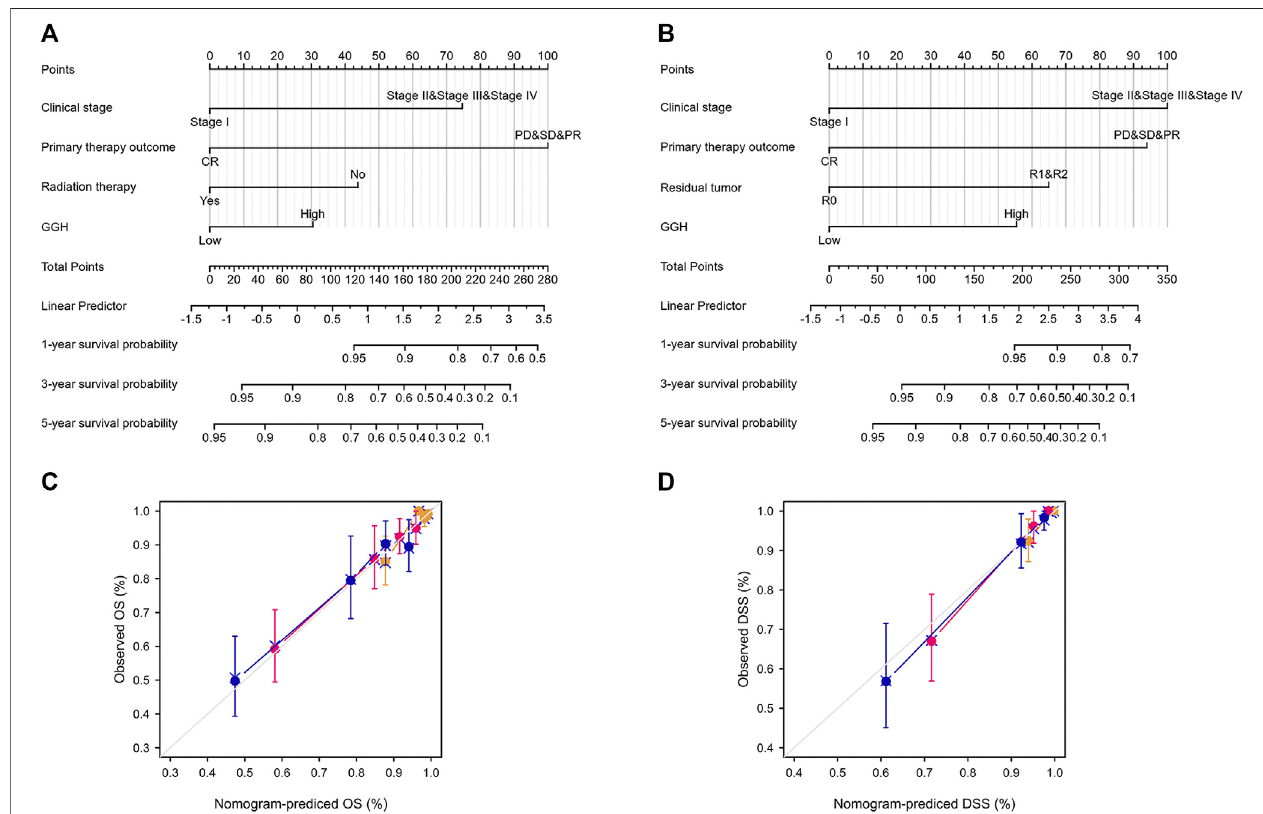
FIGURE 5 | Construction and performance validation of GGH-based nomograms for UCEC patients. (A,B) Nomograms to predict the probability of 1-, 3-, and 5- years OS and DSS for UCEC patients. (C,D) Calibration plots of the sample nomograms for predicting OS and DSS probabilities showing the difference between true and predicted